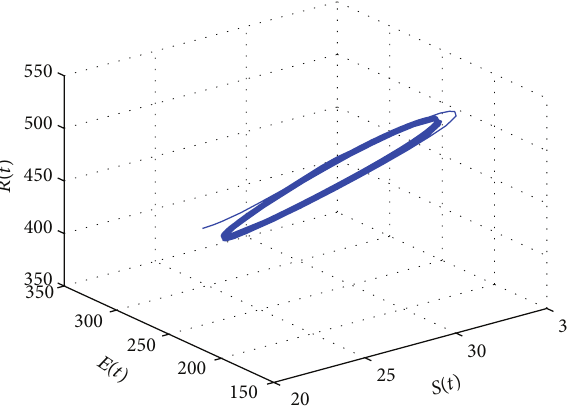
Figure 12: The phase plot of the states 𝑆 , 𝐸 , and 𝑅 for 𝜏 = 5.2300 > 5.1094 = 𝜏 0 .